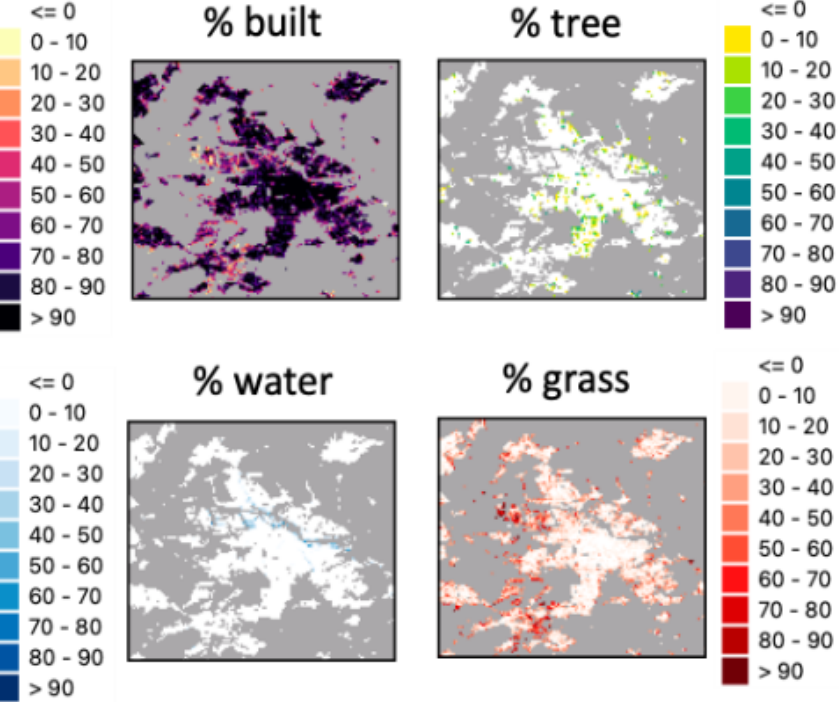
Figure 2. Percentage cover in 2010 for the built, total tree, grass, and inland-water PFTs in Amsterdam, the Netherlands, in the PFT local